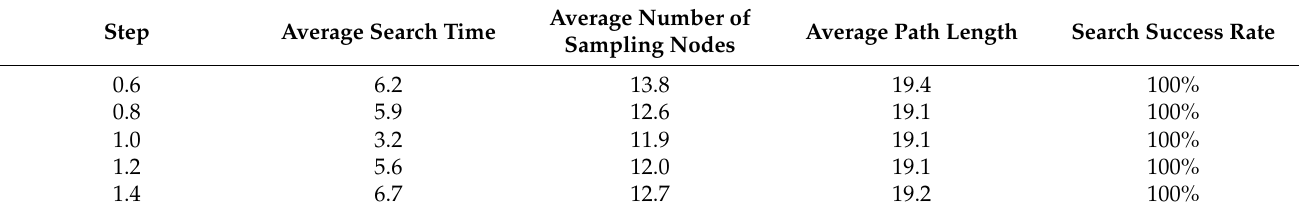
Table 4. Comparison of hybrid algorithms with different step